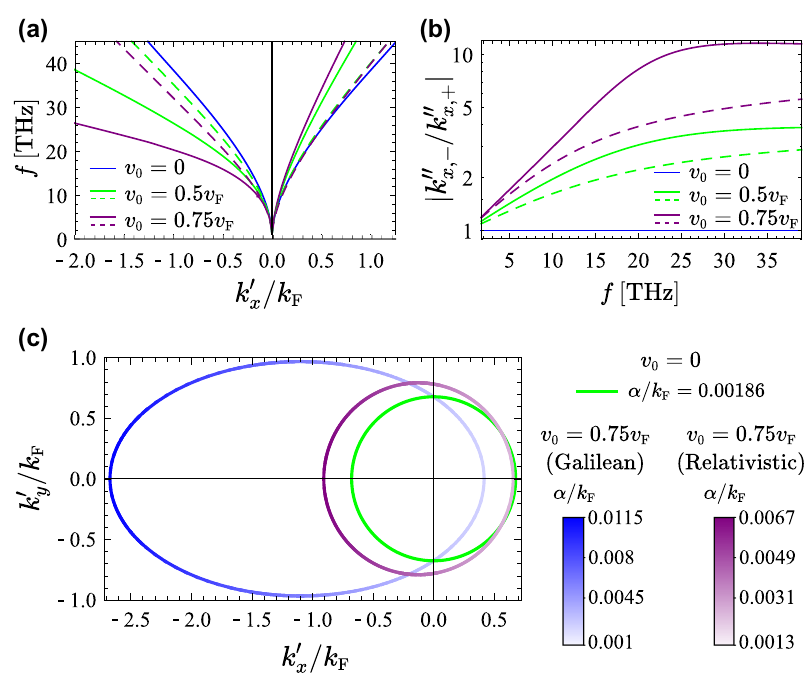
Figure 2: SPPs dispersion and isofrequency contours for a nondispersive dielectric sub- strate. (a) Dispersion of the SPPs, and (b) ratio between the attenuation constants (in logarithmic scale) for propagation along the − x and + x directions as a function of the ; frequency, for several drift velocities 𝑣 0 solid curves: Galilean model; dashed curves: relativistic model. (c) Isofrequency contours of the SPPs for 𝜔 ∕ (2 𝜋 ) = 30 THz ; the green curve is calculated without a drift current = 0), and the blue and purple curves bias ( 𝑣 0 = 0.75 𝑣 ),using with a drift current bias ( 𝑣 0 F the Galilean model (blue curve) and the relativistic model (purple curve). The color gradient represents the SPP attenuation constant ( 𝛼 = k ′′ sgn ( k ′ )). In all the results 𝜇 = 0.1 eV, 𝜏 = 1.7 ps and 𝜀 = c r , s